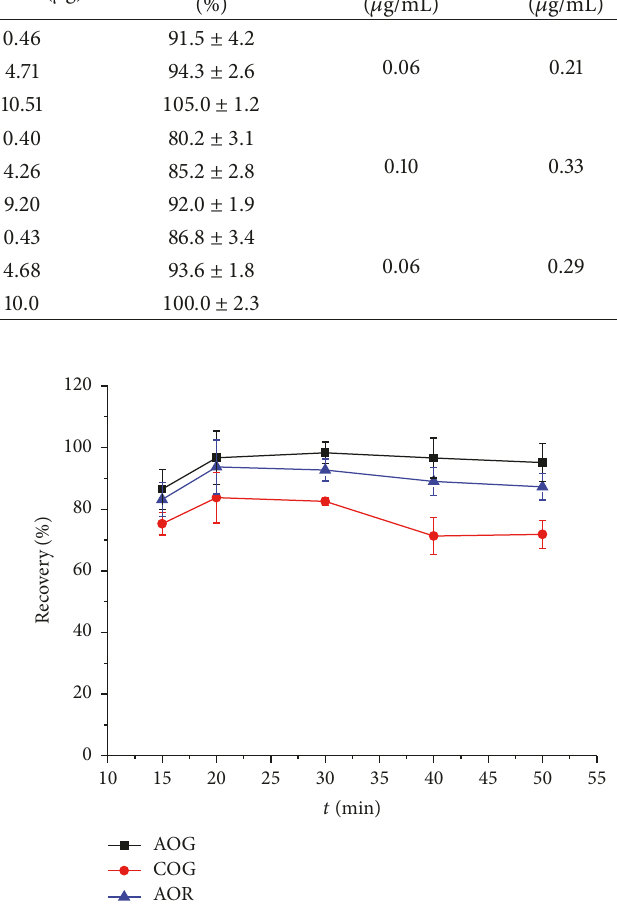
Figure 6: Effect of extraction time on the recoveries of the three dyes.Sample/DES-1-2:0.1 g/mL,temperature:50.0 ∘ C,andultrasonic power: 75